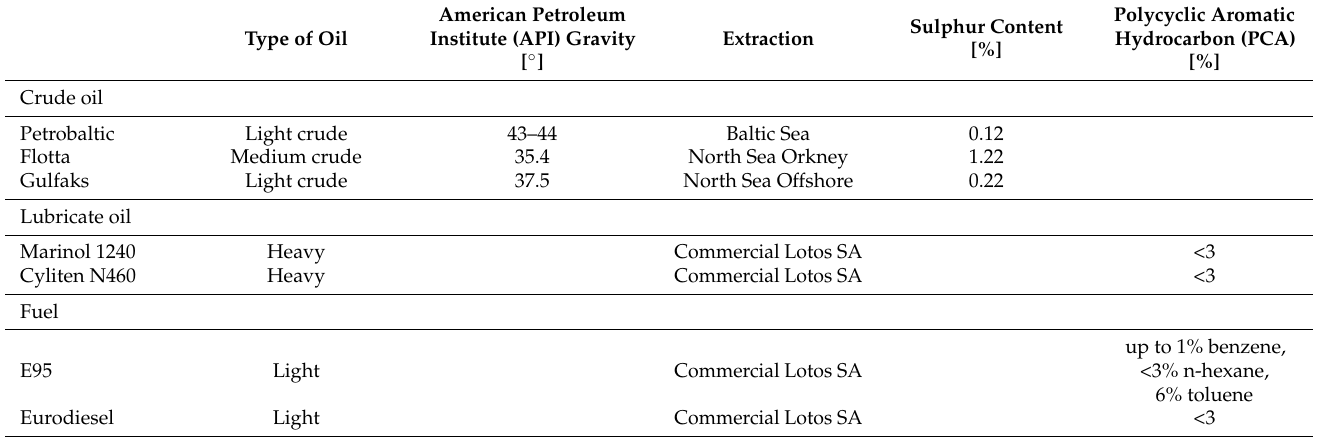
Table 2. Properties of several kinds of oils used to prepare the mixture of